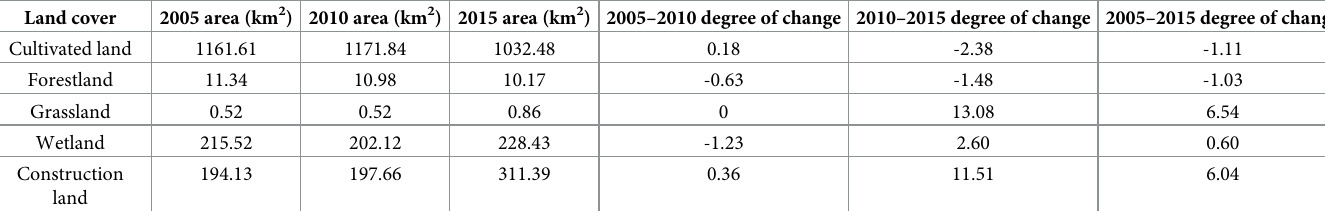
Table 5. Land cover area and degree of change of the Xiongan New Area in 2005, 2010 and 2015.